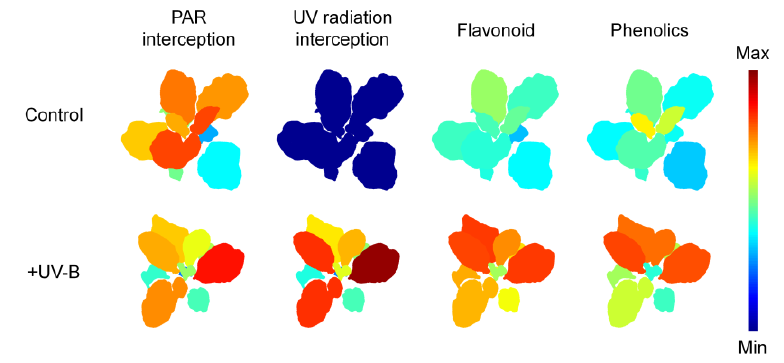
Figure 7. Representative distributions of average radiation interception and phenolic compound contents on individual leaves of kales under the control and UV-B treatments ( n = 3). PAR, photosynthetically active radiation in the range of 400–700 nm; UV, biological effective UV radiation in the range of 280–400 nm. The color var indicates each range of 0–200 µ mol m − 2 s − 1 for PAR interception, 0–10 kJ m − 2 d − 1 for UV radiation interception, 0–12 mg CE g − 1 DW for flavonoids and 0–16 mg GAE g − 1 DW for phenolic